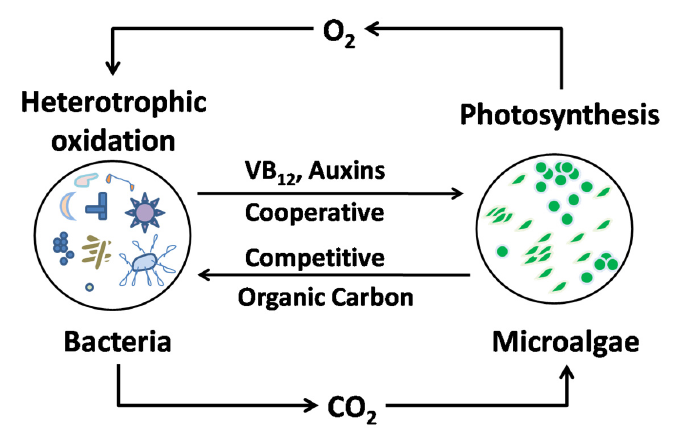
Figure 14. Cooperation and competition relationships between microalgae and bacteria (VB 12 : vitamin B 12 ). Reproduced with permission from Xiong et al . , Environ. Int. [169]; published by Elsevier, 2021. B 12 ). Reproduced with permission from Xiong et al., Environ. Int. [169]; published by Elsevier, 2021.